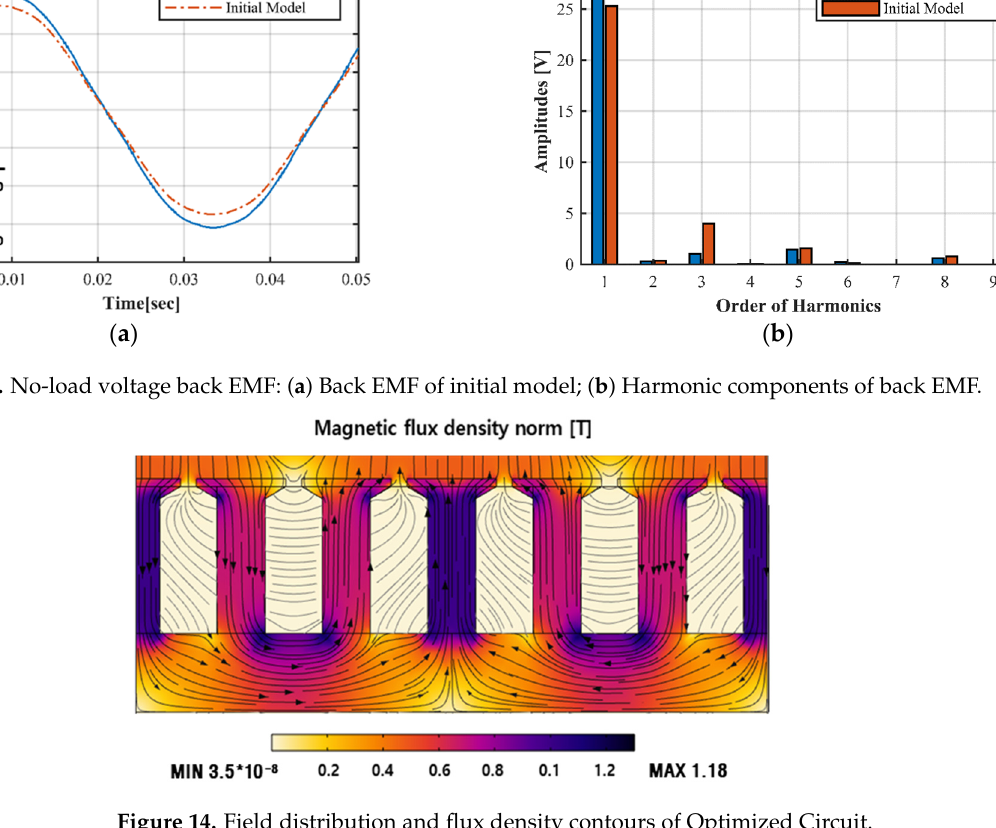
Figure 14. Field distribution and flux density contours of Optimized Circuit.